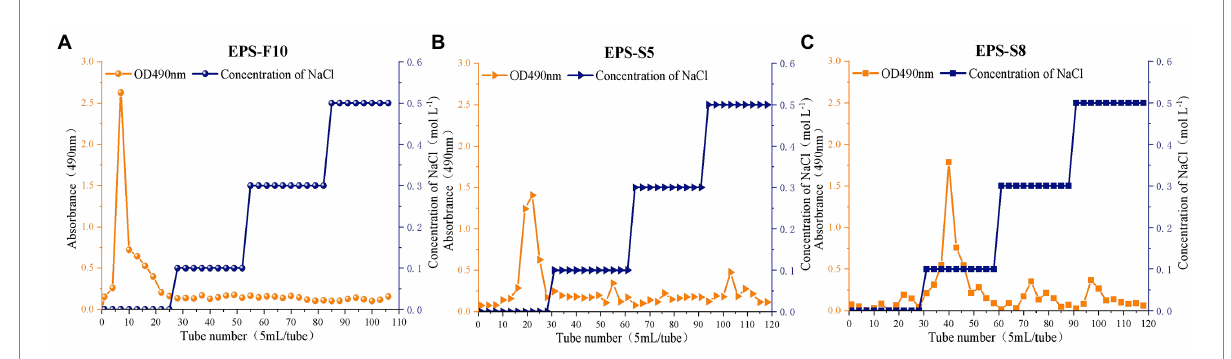
FIGURE 1 The elution curves of extracellular crude EPS-F10 (A) , EPS-S5 (B) , and EPS-S8 (C) by anion exchange column chromatography.